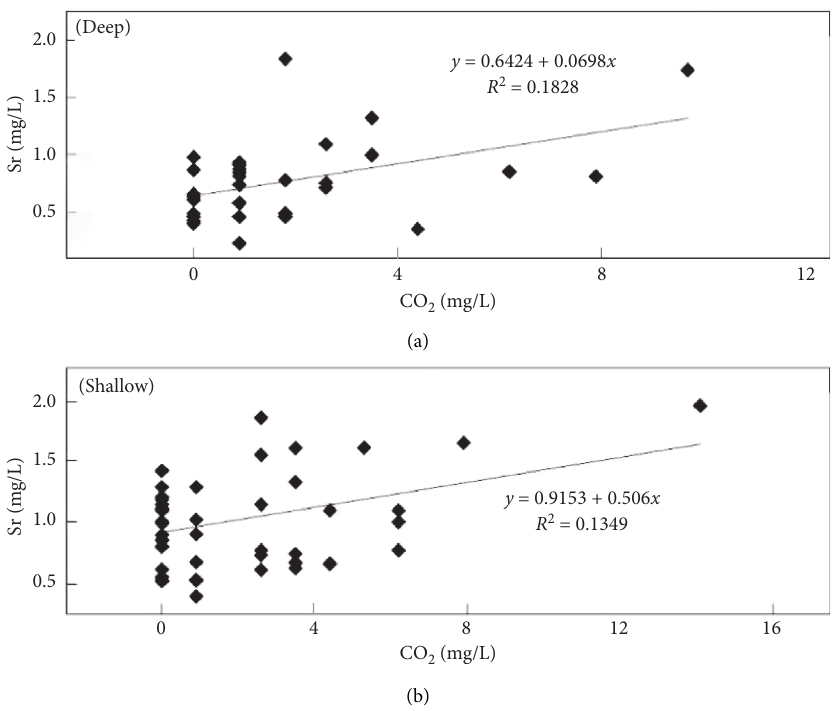
Figure 4: Relationship between strontium and free carbon dioxide in shallow and deep